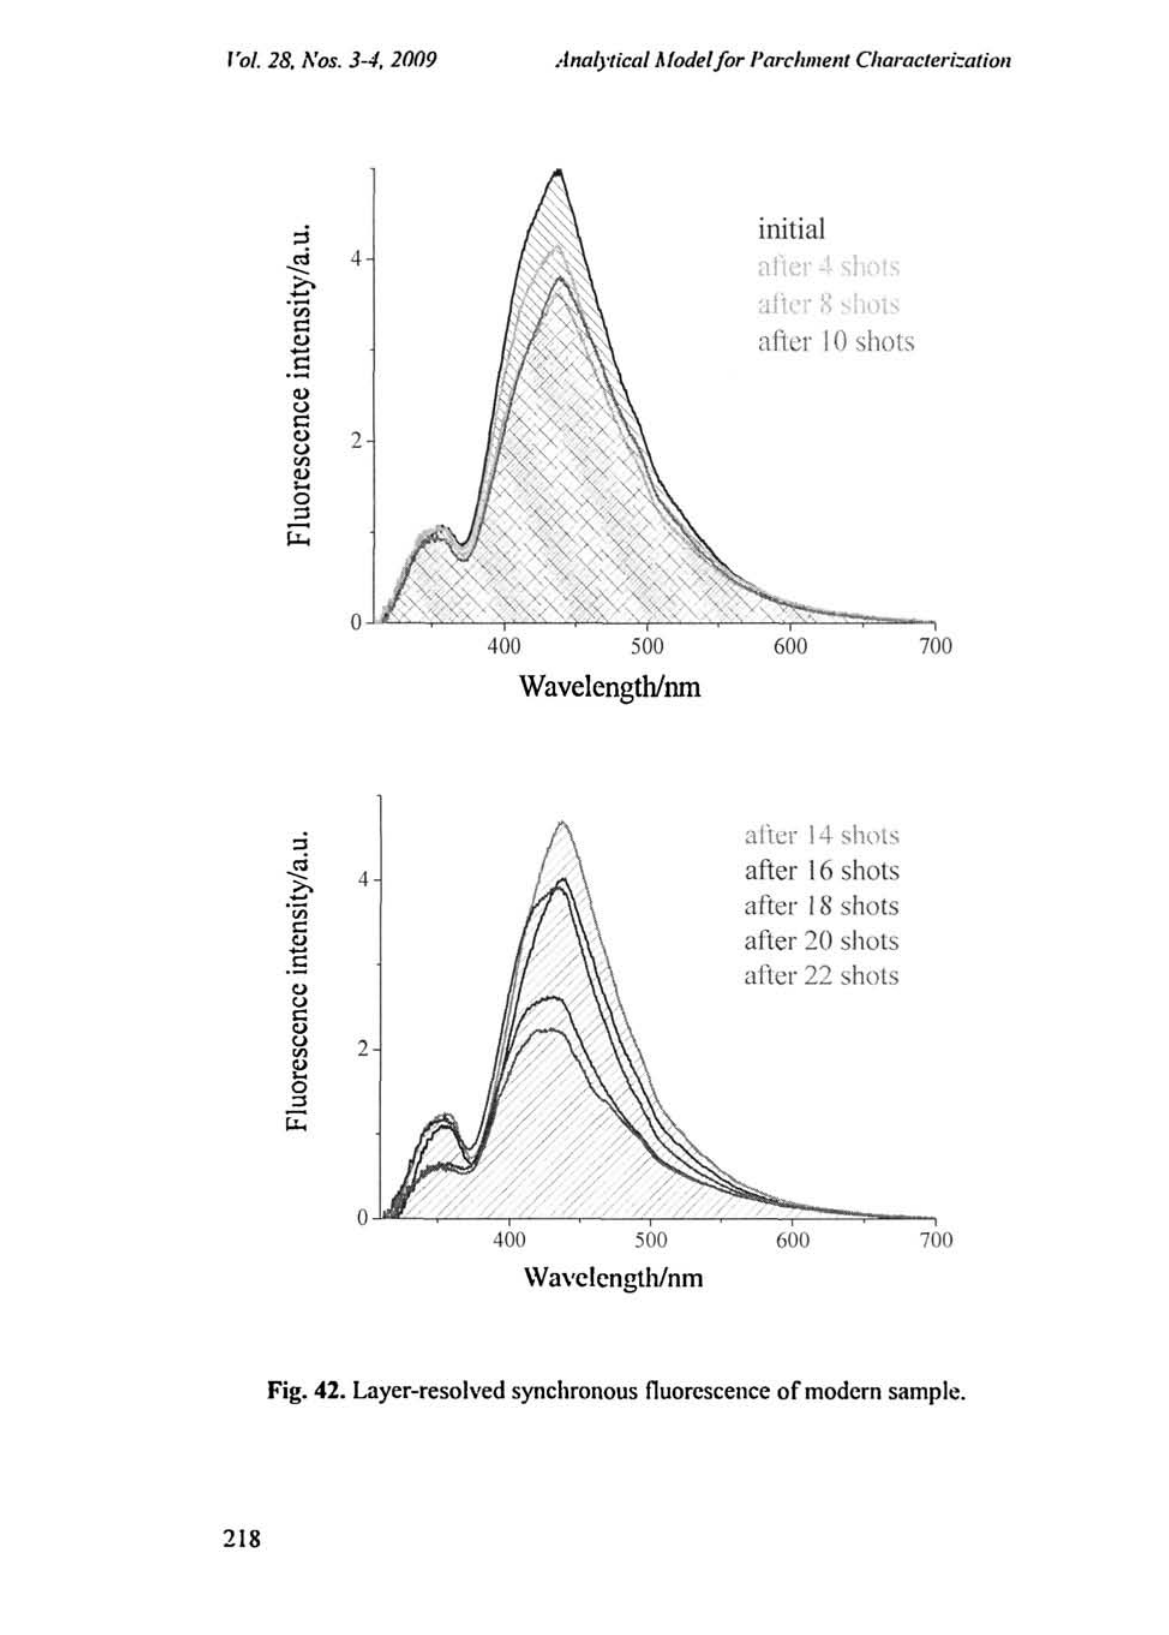
Fig. 42. Layer-resolved synchronous fluorescence of modern